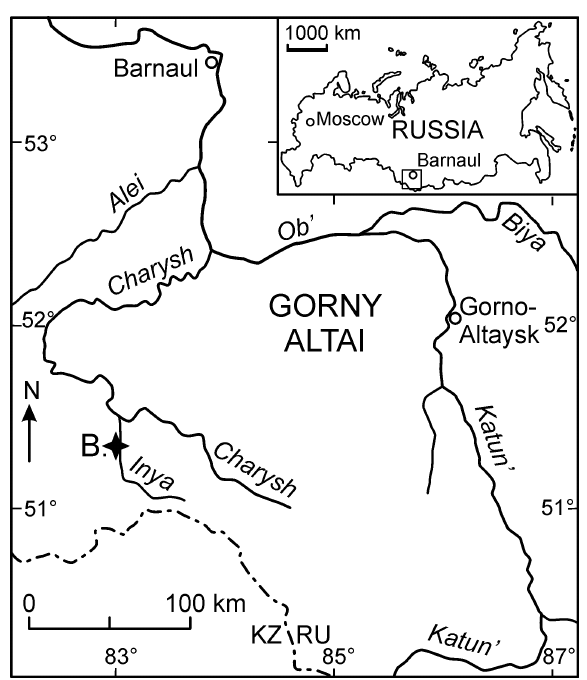
Fig. 1. Location of the Burovlyanka section (B.) in the Gorny Altai region. KZ, Kazakhstan; RU,